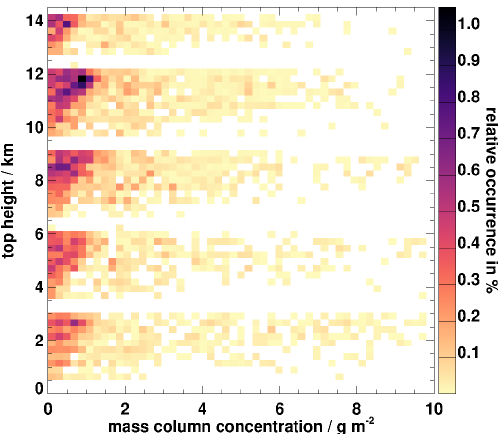
Figure 6. Probability of detection (POD) as a function of mass load after the application of Eq. 4 and of a threshold of 0.1gm − 2 to the retrieved